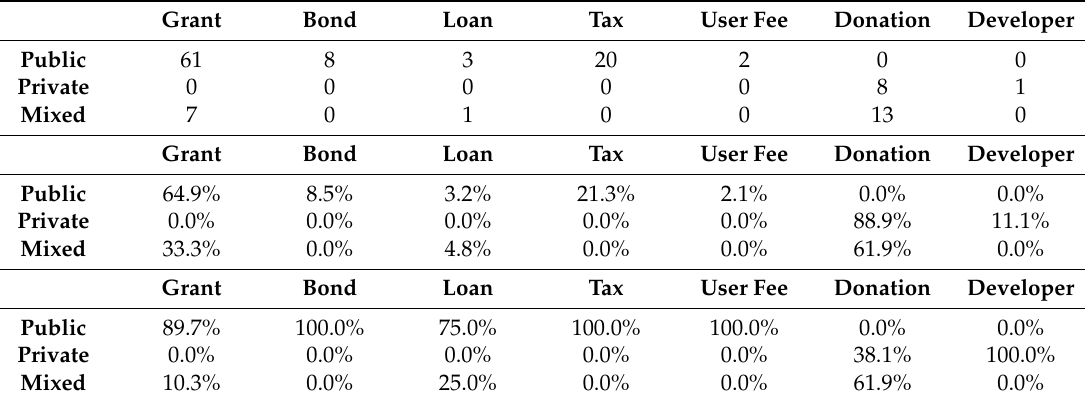
Table 2. Distribution of financial tools by financial